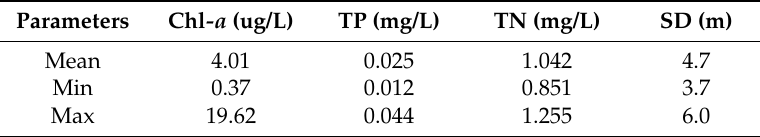
Table 2. The population parameter values measured in Lake Qiandaohu for all seasons. Parameters